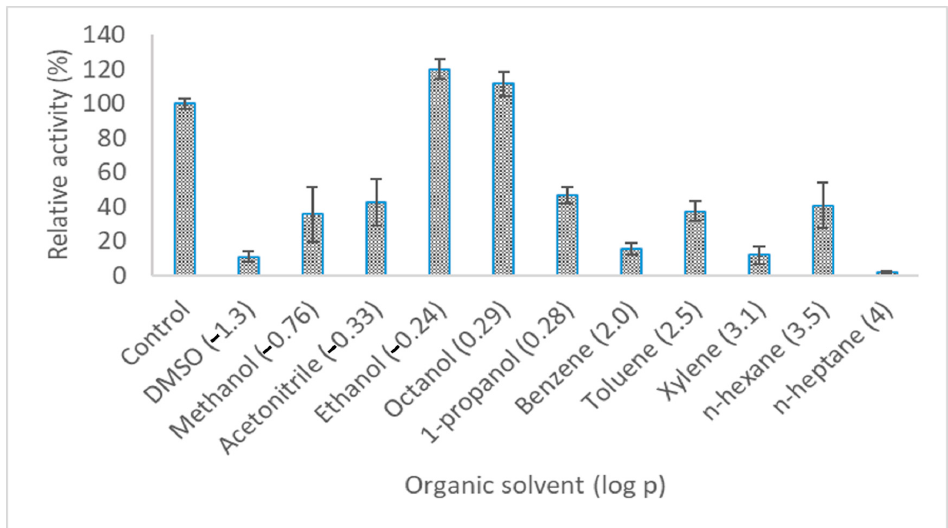
Figure 9. Effect of organic solvents on LIP2 lipase activity. The LIP2 lipase was treated with various organic solvents for 30 min. The lipase assay was tested by using p NP myristate as a substrate at 30 °C in Tris-HCL (pH 9.0). The relative activity was calculated based on the percentage of activity for control. Error bars indicate standard deviation of means ( n = 3). The absence of bar indicates that the errors were smaller than symbols and bars.